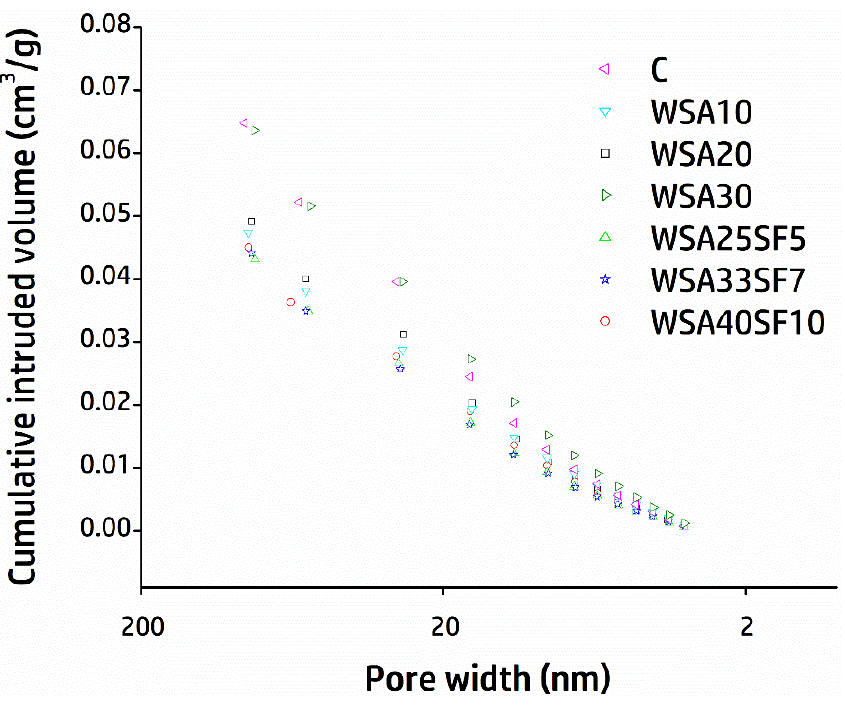
Figure 8. Comparison of the cumulative nitrogen intrusion volumes versus pore widths for control, binary (C/WSA), and ternary (C/WSA/SF) paste samples after 91 days of curing. binary (C/WSA), and ternary (C/WSA/SF) paste samples after 91 days of